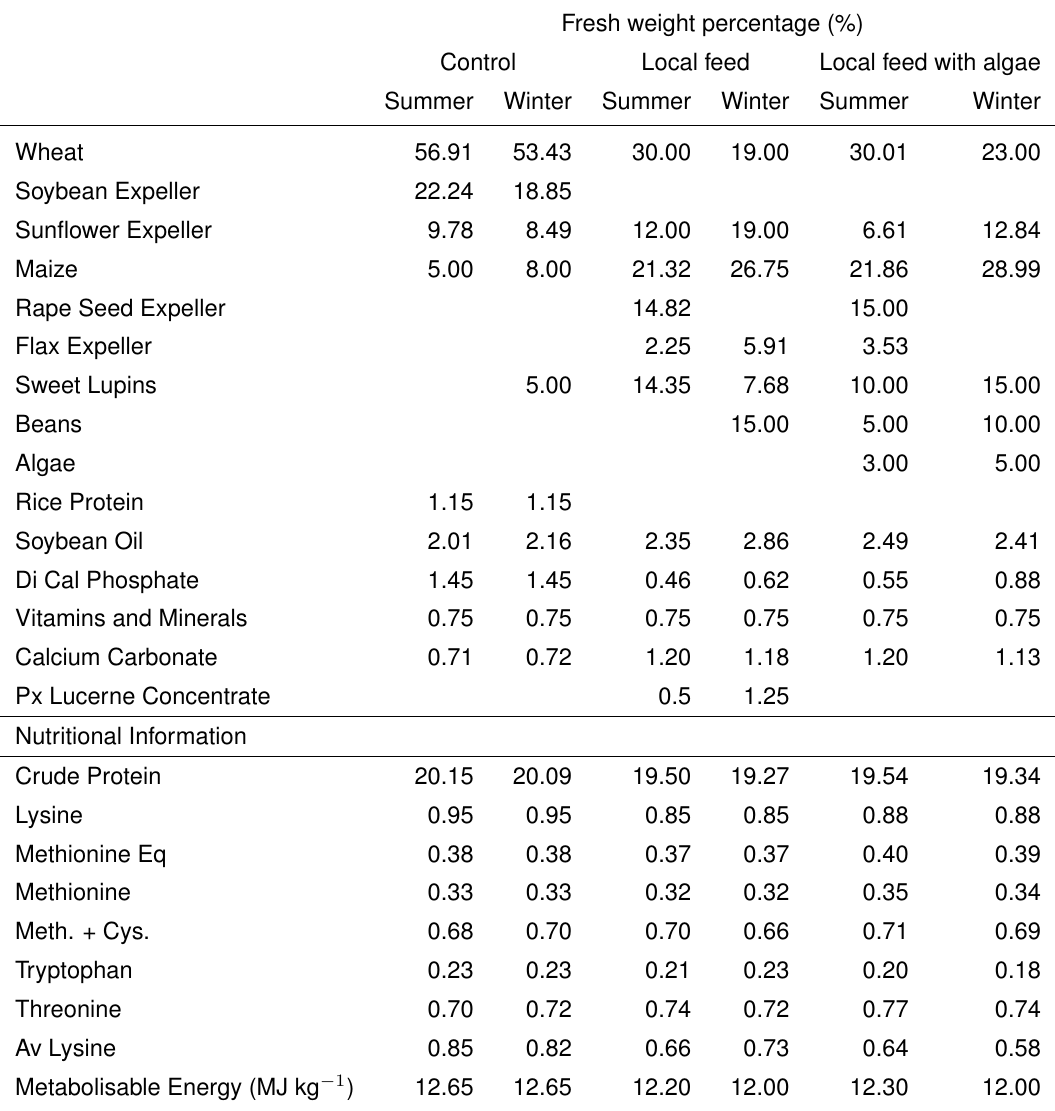
Table 1. Diet ingredients and calculated nutrient contents including amino acid profiles (data provided by Hi Peak feeds [16]).